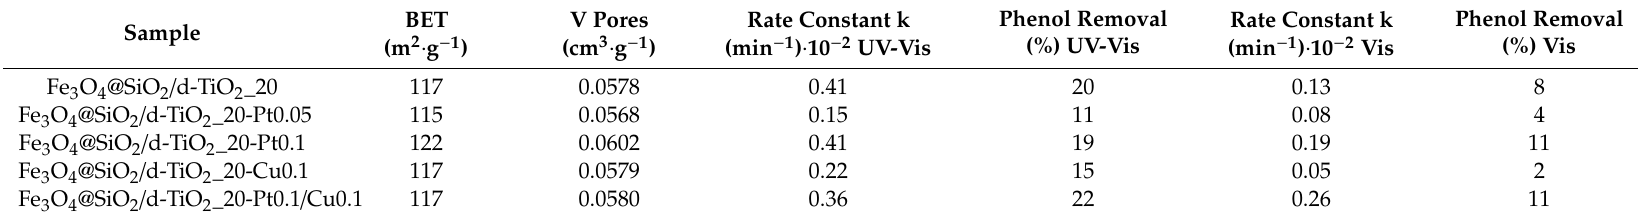
Table 2. Physicochemical and photocatalytic characteristics of the obtained magnetic Fe 3 O 4 @SiO 2 / d-TiO 2 -Pt / Cu